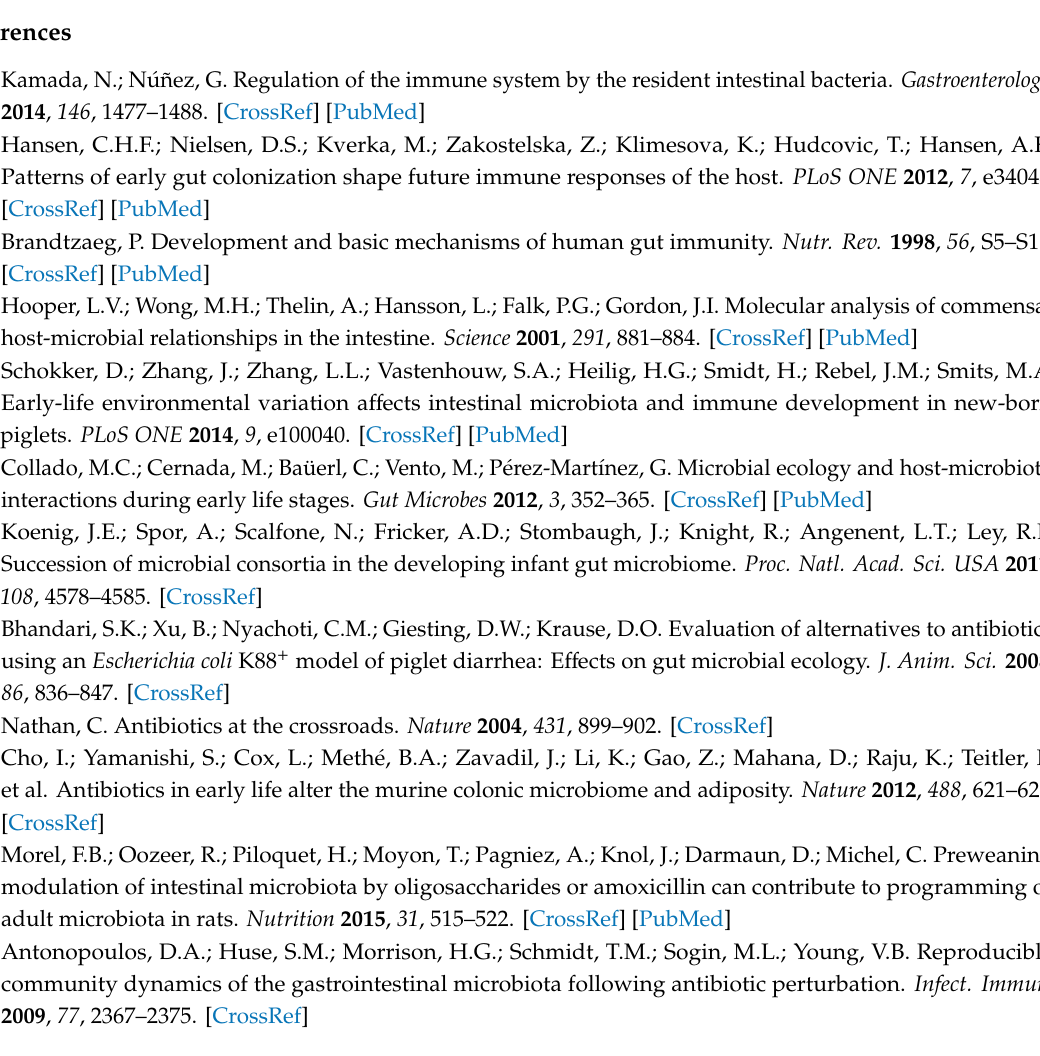
Figure S1: E ff ects of early intervention with maternal fecal microbiota and antibiotics on intestinal development gene of the ileum mucosa among the amoxicillin (AM), fecal microbiota transplantation (FMT) and control (CO) groups on days 7 and 21, Figure S2: The qPCR validation of the RNA-seq. The results are displayed as the values of fold changes in the CO group on days 7 and 21, and the qPCR data are presented as the means ± SEM (n = 5). Values with di ff erent lowercase letter superscripts indicate a significant di ff erence ( p < 0.05), and those with the same letter superscripts indicate no significant di ff erence ( p > 0.05). CO: control; AM: amoxicillin; FMT: fecal inducible T cell costimulator. Table S1: RNA and sequencing data quality control results, Table S2: Primers lists used for real-time PCR assay in this study, Table S3: The regulated gene ontology (GO) terms in the ileum mucosa of piglets in the amoxicillin (AM), fecal microbiota transplantation (FMT) and control (CO) groups on days 7 and